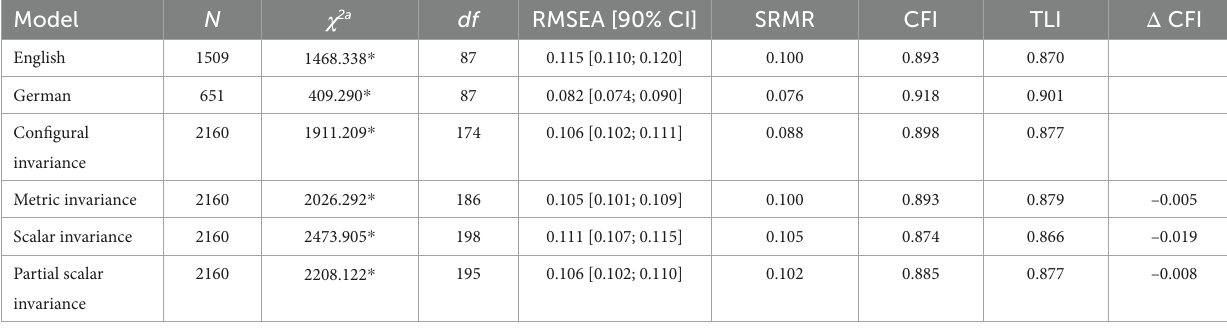
TABLE 2 Fit indices for single CFAs and measurement invariance models across languages.